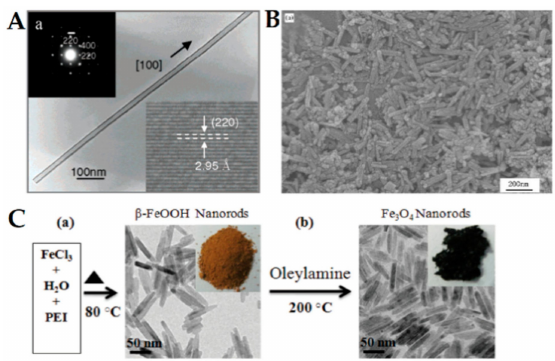
Figure 1. ( A ) TEM image of a Fe 3 O 4 nanotube. Upper inset: Selected area electron di ff raction of the nanotube. Lower inset: HRTEM image taken on the tube wall. Reproduced from [85] with permission from American Chemical Society, 2020. ( B ) SEM image of magnetite nanorods described in [71]. Reproduced from [71] with permission from Elsevier, 2020. ( C ) Scheme of the two-step synthesis of magnetite nanorods. Adapted from [88] with permission from Royal Society of Chemistry,